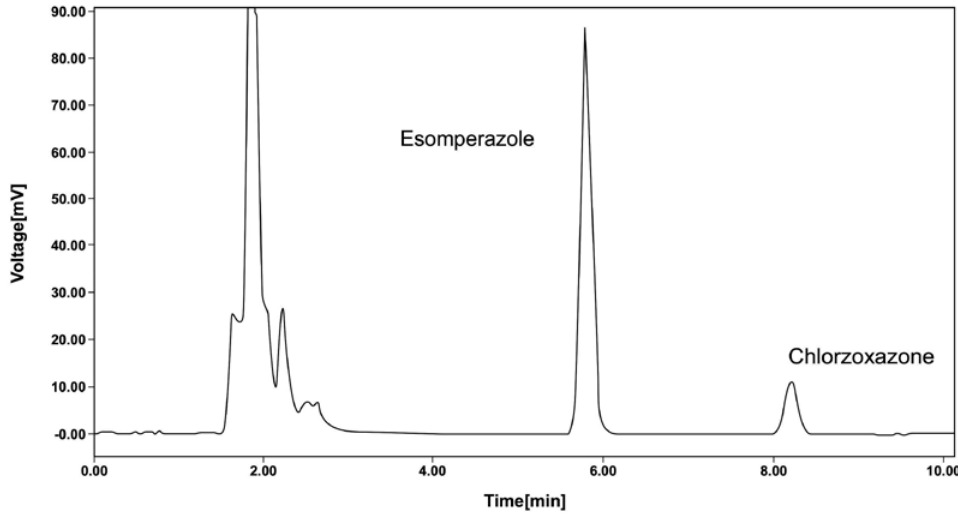
FIGURE 5 - Chromatogram of chlorzoxazone in plasma taken from a rat after IV administration and spiked with esomeprazole (44